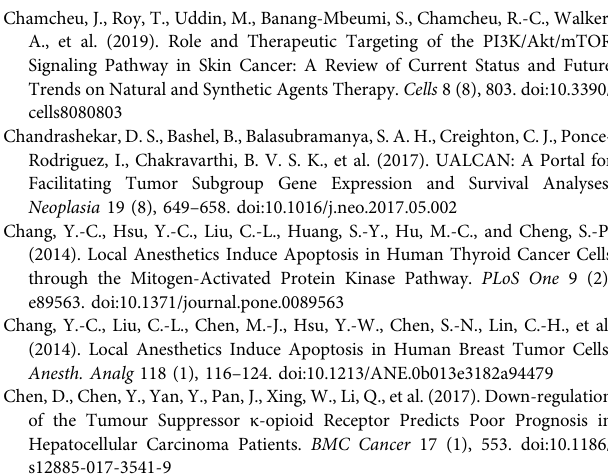
Supplementary Figure S3 | Pathway enrichment analysis of SCN7A by LinkedOmics and Metascape. (A) Pathway enrichment analysis of KEGG pathways by LinkedOmics. (B) Pathway enrichment analysis of the Panther pathway by LinkedOmics. (C) Pathway enrichment analysis of the Wiki pathway by LinkedOmics. (D) Pathway and function enrichment analysis of SCN7A and 200 most frequently altered neighbouring genes in HCC by Metascape. (E) Network of enriched terms in pathway and functional enrichment analysis by